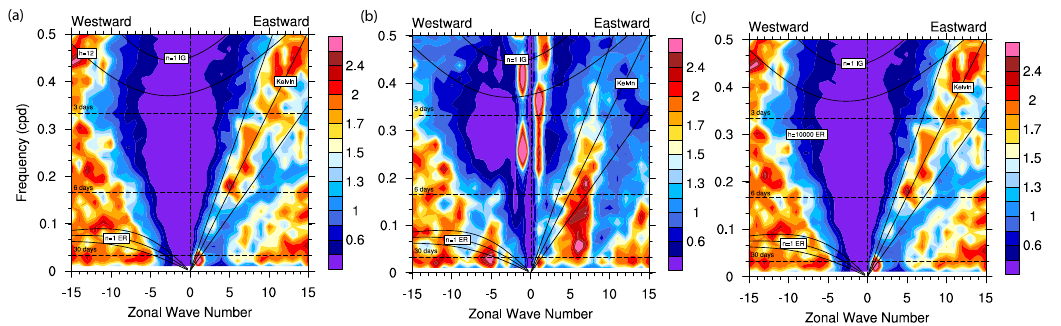
Figure 13. Wavenumber-frequency spectrum of the 200 hPa zonal wind field associated with the Kelvin modes. The full spectrum of vertical modes is presented in panel ( a ), while panels ( b , c ) refer to the barotropic and baroclinic components,